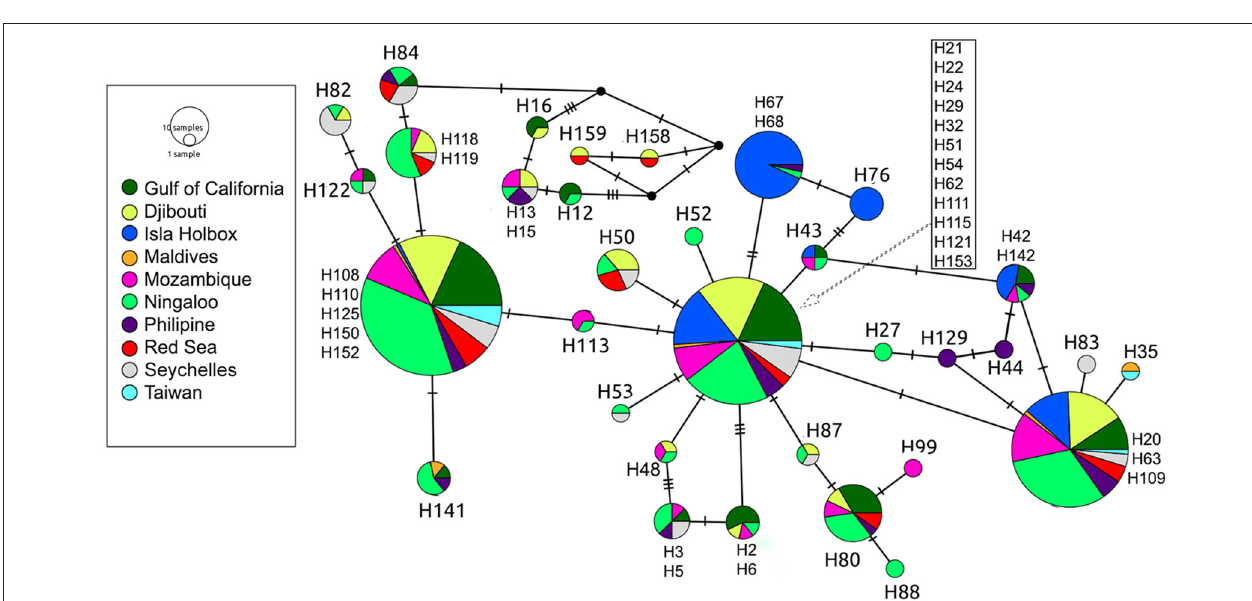
FIGURE 3 | Median-joining population network based on control region sequences of R. typus . Each circle represents a unique haplotype, with colors depicting the proportion of individuals from the various sample sites sharing the haplotype. Ticks on connecting lines indicate mutational steps between